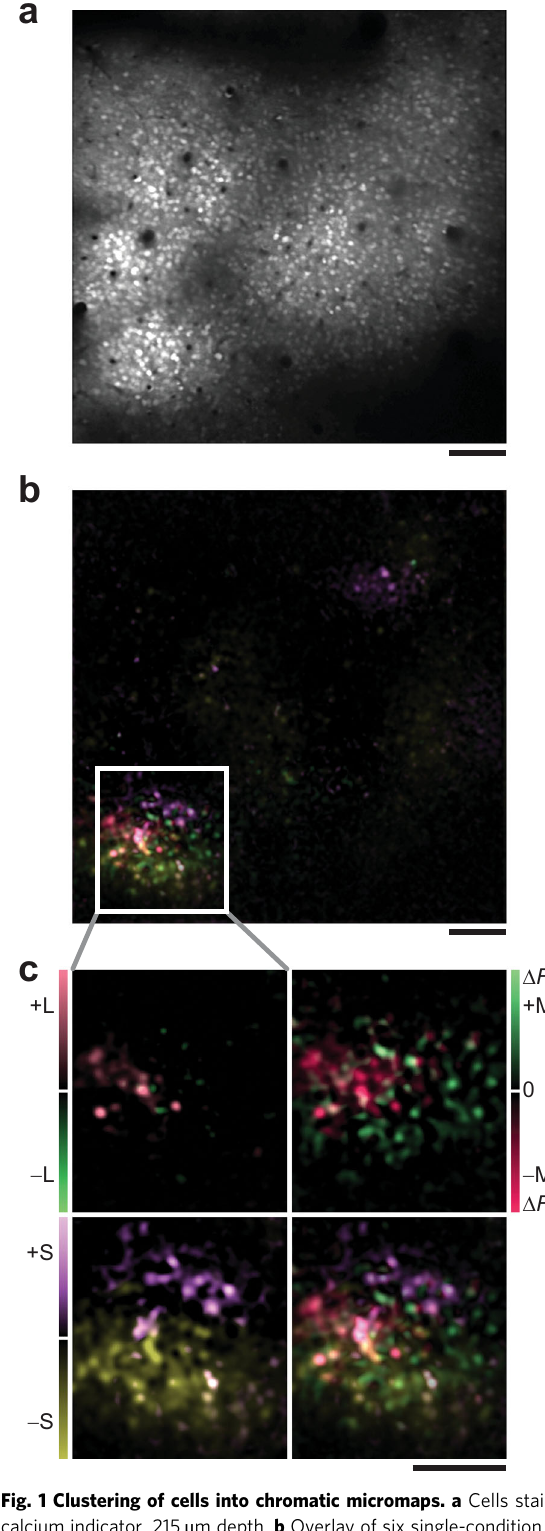
Fig. 1 Clustering of cells into chromatic micromaps. a Cells stained with calcium indicator, 215 μ m depth. b Overlay of six single-condition Δ F maps obtained with spatially uniform stimuli, from fi eld of view in a . Responses are to + / – L, + / – M, and + / – S conditions. c Magni fi cation of cell cluster in b . Each panel has two color-coded Δ F maps, showing responses to sign- speci fi c stimulation of a single cone type. Maps summed and rescaled at bottom-right (see Methods). Same color code in b and c , approximating color of stimulus. Scale bars, 100 μ